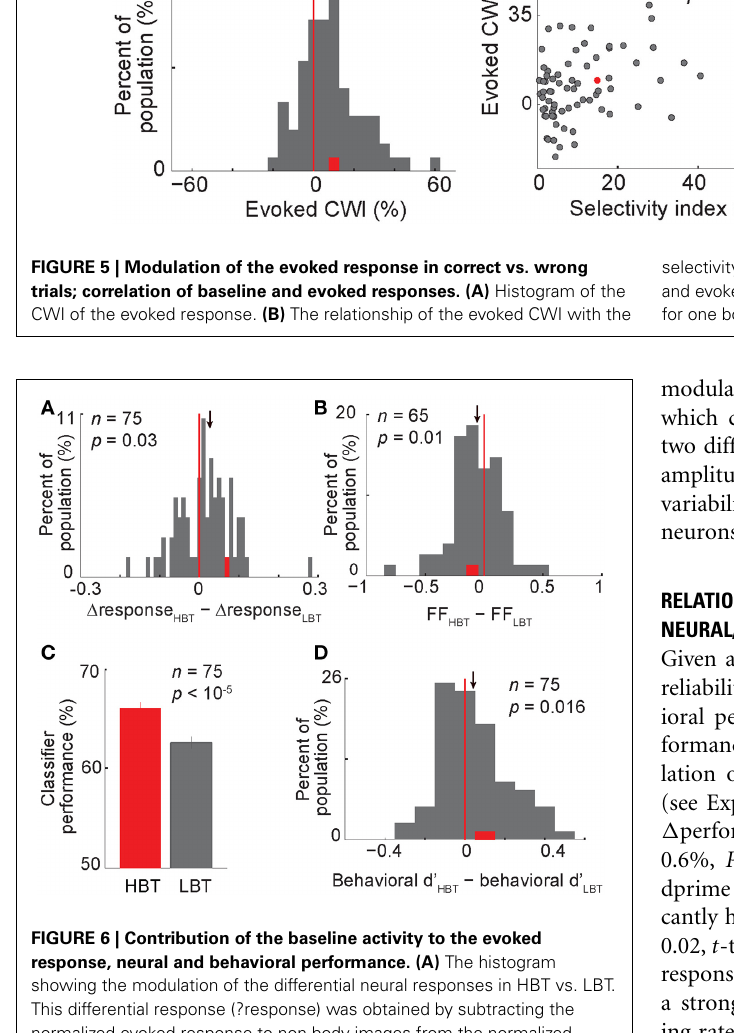
FIGURE 6 | Contribution of the baseline activity to the evoked response, neural and behavioral performance. (A) The histogram showing the modulation of the differential neural responses in HBT vs. LBT. This differential response (?response) was obtained by subtracting the normalized evoked response to non-body images from the normalized evoked response to body images. One data point ( X = 0.91) was larger than the X-axis limit and is not shown here (B) The modulation of the rate-matched Fano factor in HBT vs. LBT. (C) The performance of a neural classifier in HBT and LBT. Error bars indicate the s.e.m. over 1000 repetitions of the classification in each condition. (D) The modulation of the behavioral dprime (d (cid:4) ) in HBT vs. LBT. Conventions as described in Figure 2